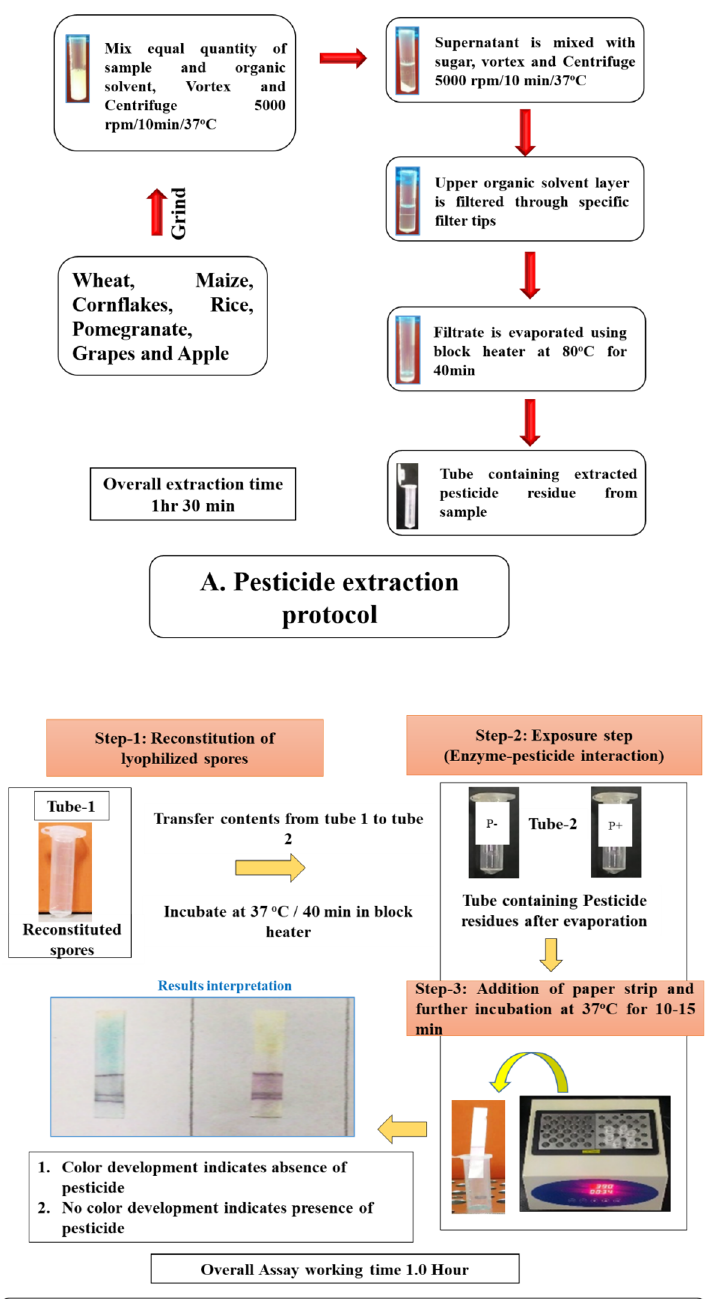
Figure 1. Paper strip assay for rapid detection of pesticide residues in Food. ( A ) Protocol for extraction and screening of Pesticide residues in food products. ( B ) Color of Paper strip before (Colorless) and after (Blue) incubation in the detection of pesticide residues. (+ ve) sample—Colorless, (− ve) sample blue